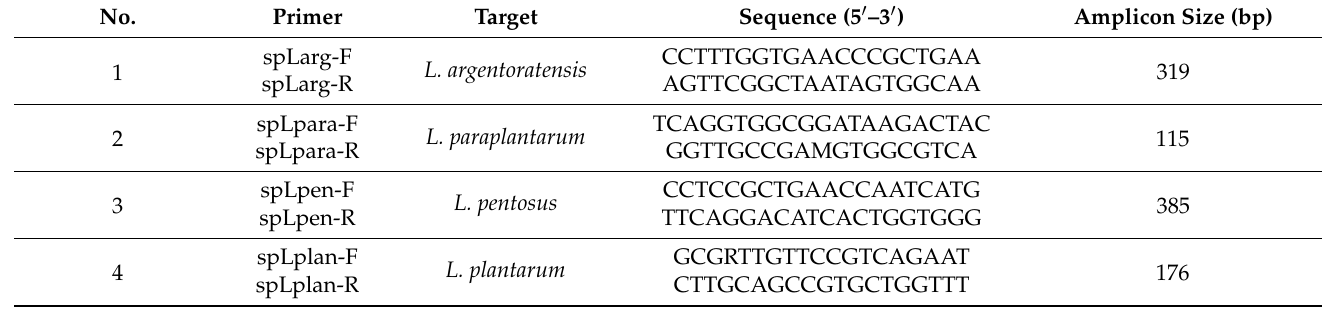
Table 3. Species-specific primers used in this study.